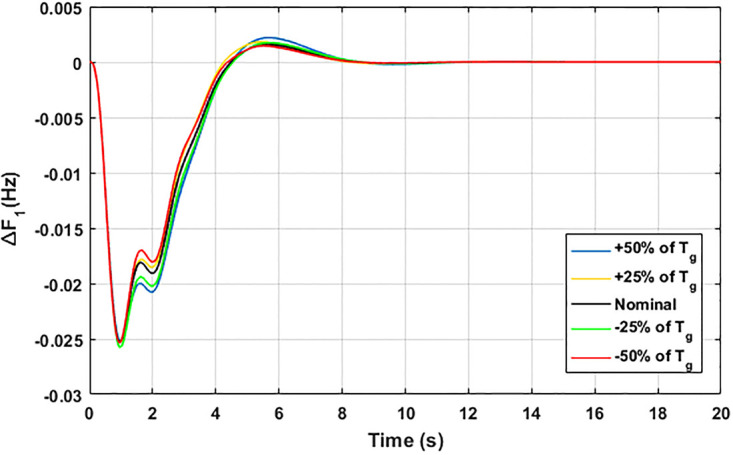
Results for variation in Tg with ΔF1.